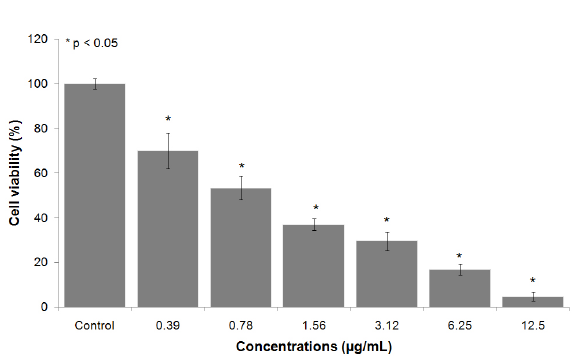
Figure 5. Trypanocidal activity against epimastigote forms of T. cruzi , after five days of culture with different concentrations (12.5-0.39 µg/mL) of B. leucurus venom. The initial cell density was 1 x 10 6 cells/mL. The graph presents mean ± SEM (n = 3). *p < 0.05 compared to the corresponding control group.